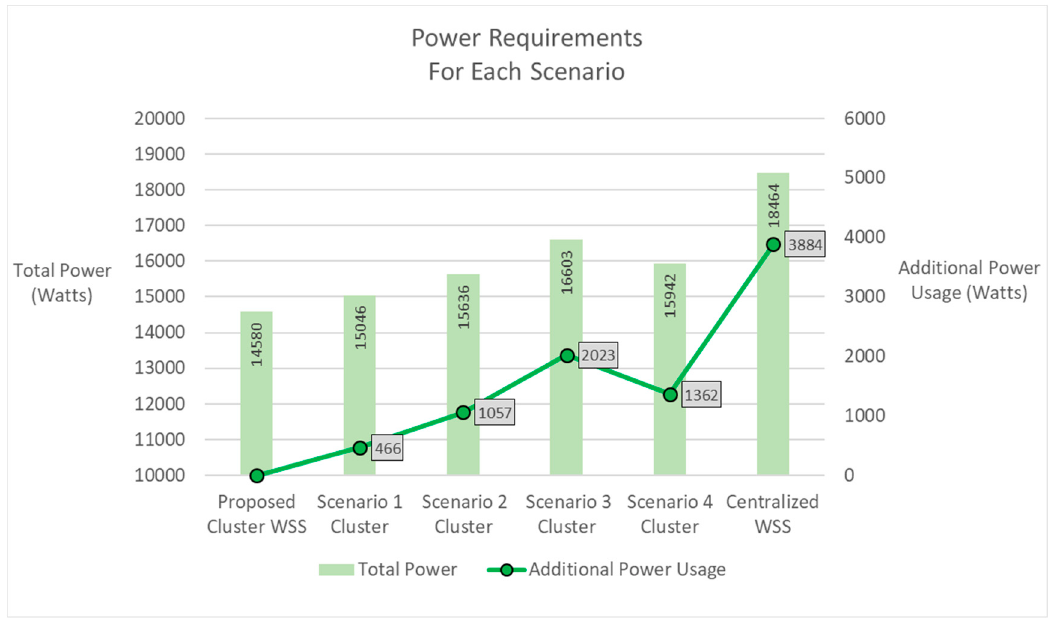
Figure 12. The bar graph represents the total power requirements per cluster. The line graph represents the excess power of the WSS scenarios compared to the proposed WSS.